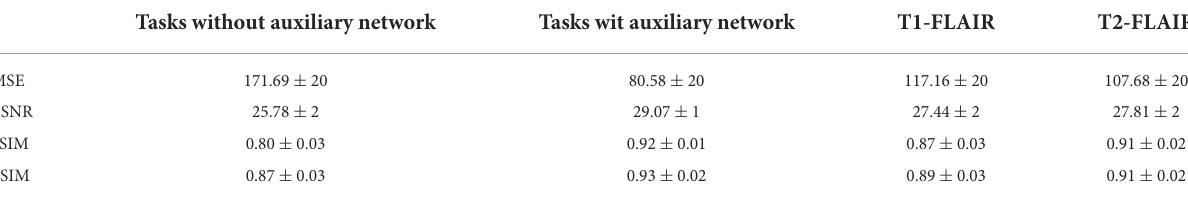
TABLE 1 Self-supervised learning performance index and cooperative learning performance